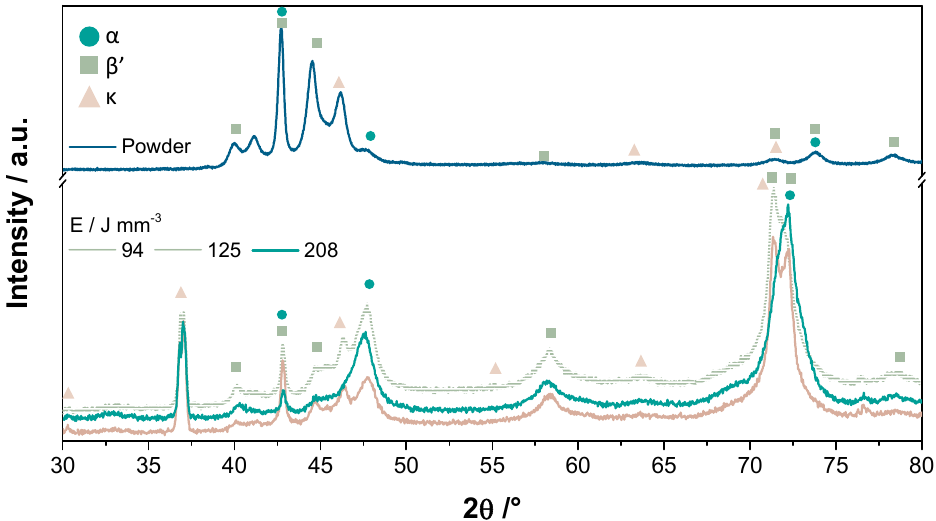
Figure 5. The X-ray diffraction pattern of powder alloy and as-built samples fabricated with different Figure 5. The X ‐ ray diffraction pattern of powder alloy and as ‐ built samples fabricated with differ ‐ volumetry energy densities ent volumetry energy densities (E).